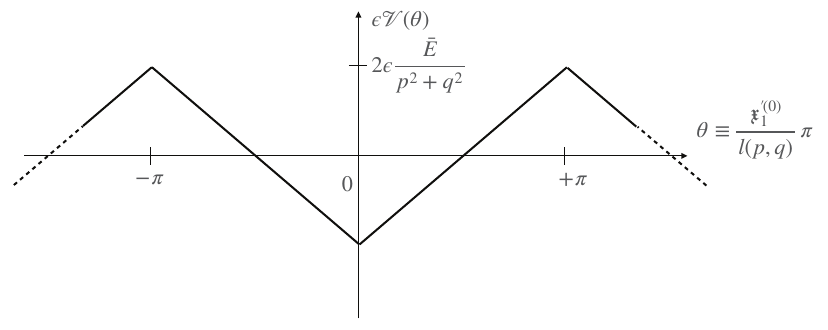
Figure 5: The form of the potential that appears in the study of a nonlinear resonance in our